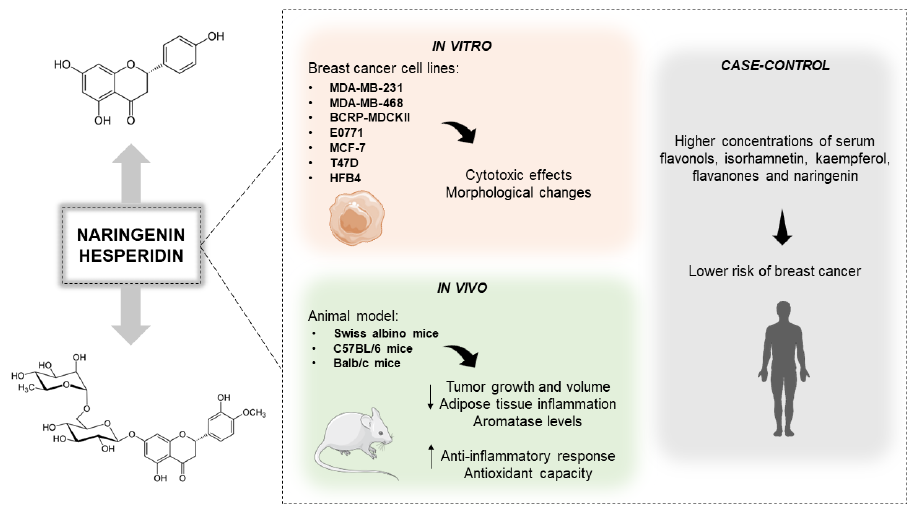
Figure 3. Schematic depiction of antitumor activity of naringenin and Figure 3 . Schematic depiction of antitumor activity of naringenin and hesperidin.